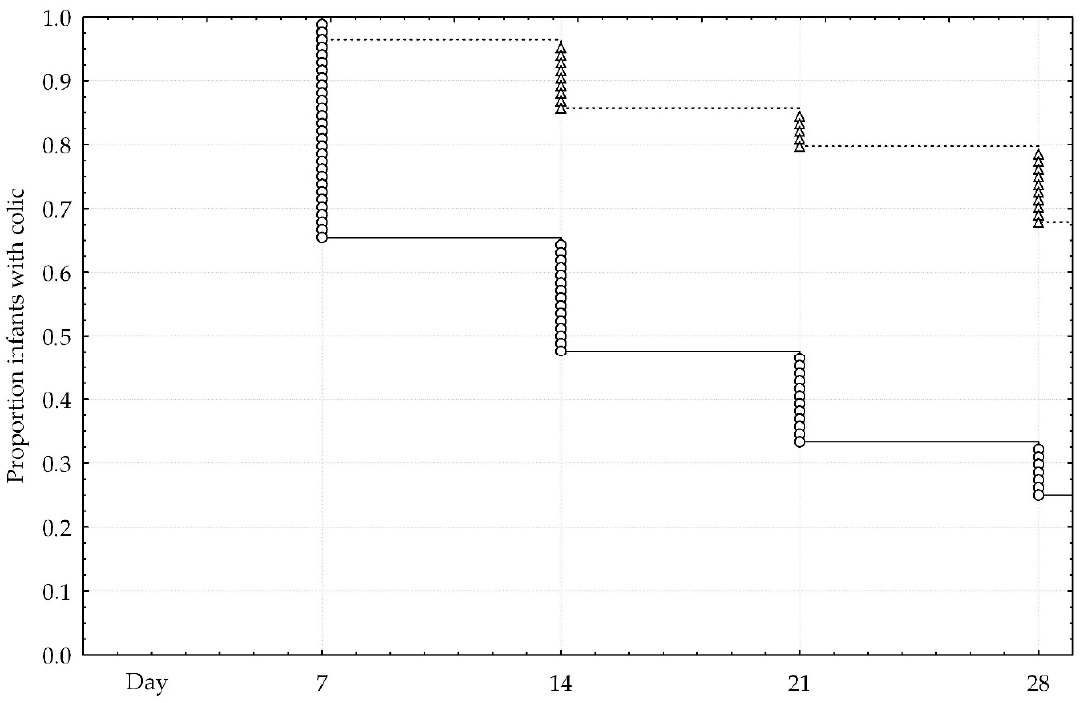
Figure 3. Recovery from colic. Solid line and round marks denote active group. Dash line and triangle marks denote control group.